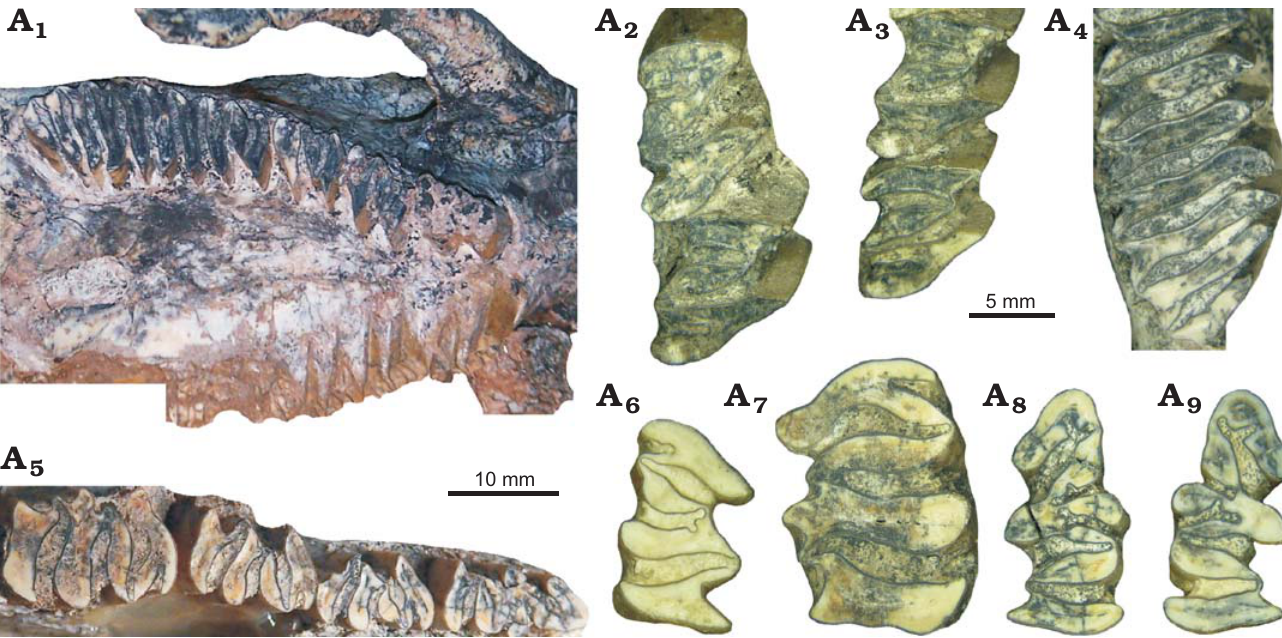
Fig. 4. Occlusal dental details of the holotype (INGEO-PV 87) of the hydrochoerine rodent Cardiatherium calingastaense sp. nov., late Miocene, Puchuzum, San Juan Province, Argentina. Right P4–M3 (A 1 ), left P4–M1 (A 2 ), left M1–M2 (A 3 ), posterior part of right M3 (A 4 ), left p4–m3 (A 5 ), right m1 (A 6 ), left m3 (A 7 ), left p4 (A 8 ), right p4 (A 9